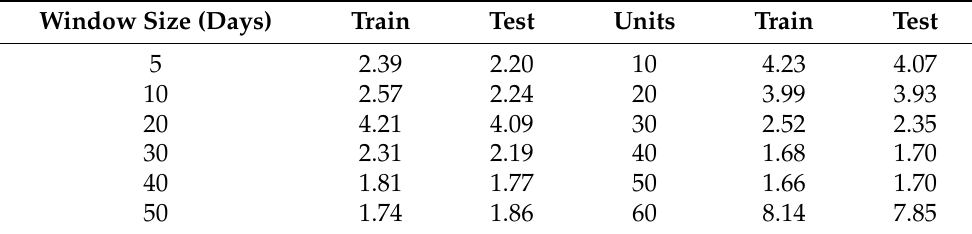
Table 4. The magnitude of RMSE errors in the test and training set, using one sample per day. Window Size